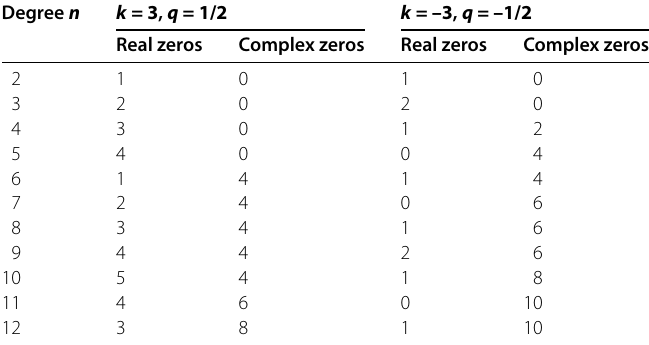
Table 1 Numbers of real and complex zeros of T ( k ) n , q ( x ) Degree n k = 3 , q = 1/2